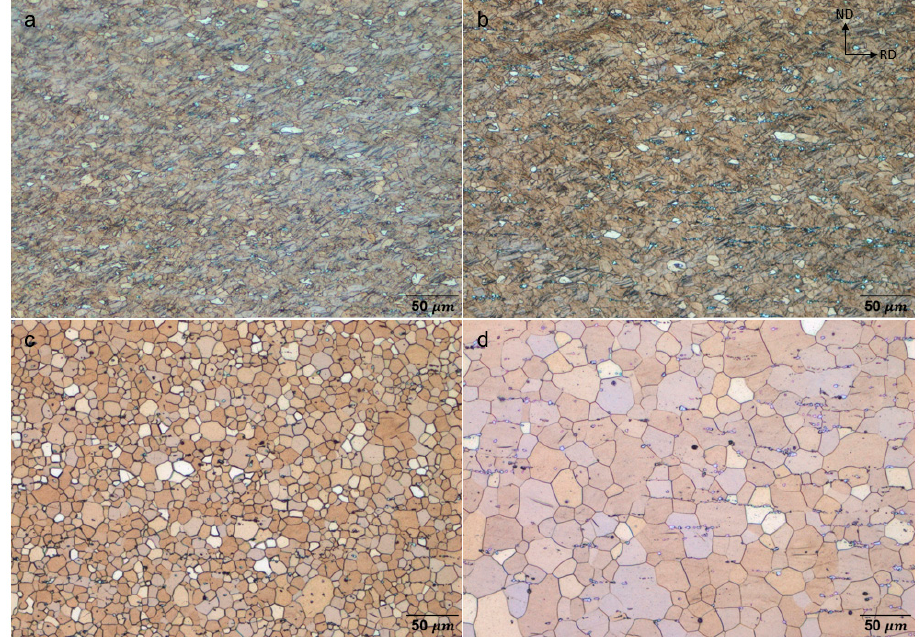
Figure 1. Optical micrographs of (upper) as-rolled and (below) homogenized ( a , c ) ZAXM2100 and ( b , d ) ZAXM4100 alloy sheets. The homogenization treatments were conducted at 350 °C for 3 h.